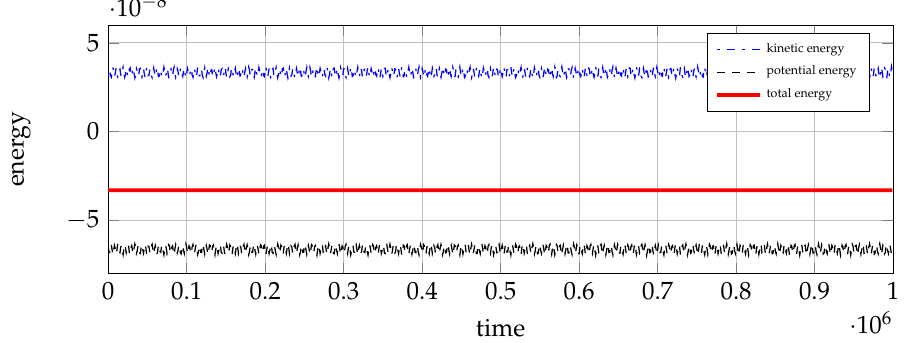
Figure 4. Kinetic, potential and total energy evolution for the numerical integration of the solar system problem for 1 million days, using family of exponential integrators with S 1 = 3, S 2 = 5 and h = 2 days.